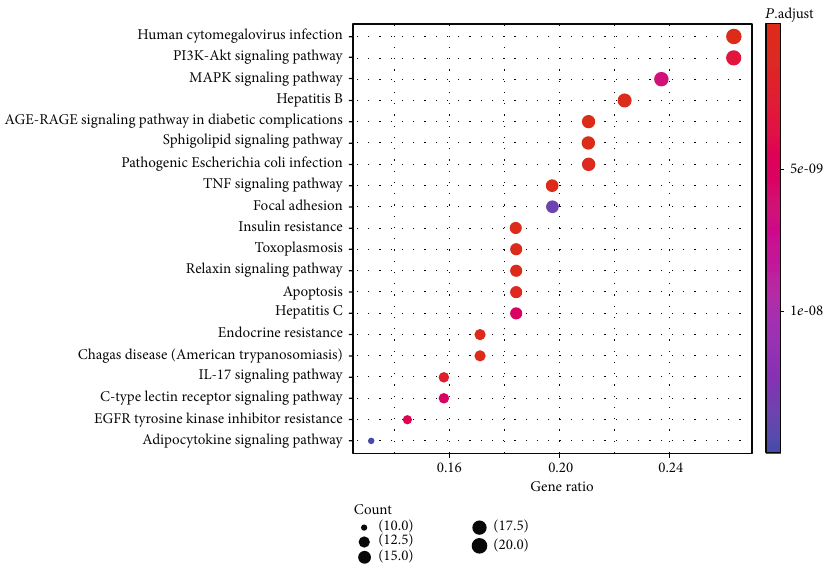
Figure 7: KEGG pathway analysis of potential targets of Cordyceps. The top 20 pathways are selected following the criteria of P < 0 : 05 . The longitudinal axis represents the name of di ff erent pathways, and the transverse axis shows the number of enriched genes. Besides, the dot size represents the proportion of the number of enriched genes to the total number of genes, which is according to the descending proportion value. And the color of the dot is displayed in a gradient from red to blue according to the ascending order of the P value.